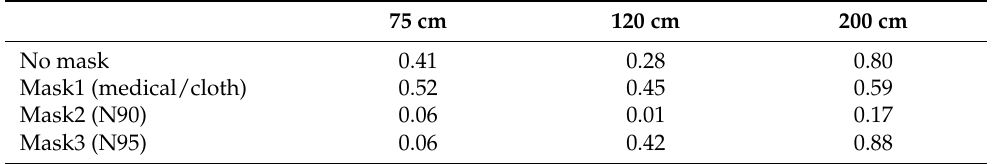
Figure 13. Respiratory signals extracted from thermal video (red) and from a reference breath belt (blue) of a subject at 75 cm with different face masks, ( a ) No face mask, ( b ) medical face mask, ( c ) N90 face mask, and ( d ) N95 face mask. Table 1. The mean absolute error between the estimated RR and the reference RR of a subject with different face masks at different detection ranges (unit: